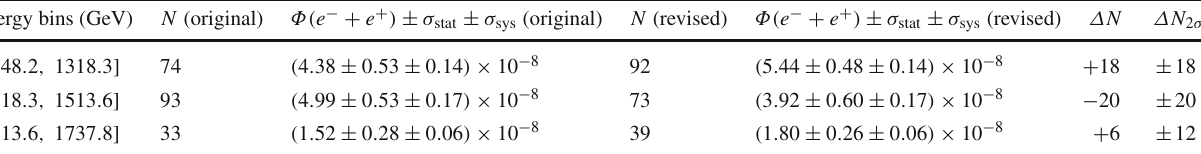
Table 1 The original and revised numbers of events and fluxes, Δ N , and Δ N 2 σ for the 1229.3 GeV bin, 1411.4 GeV bin, and 1620.5 GeV bin. Here, Δ N and Δ N 2 σ are the adjusted numbers of events and the